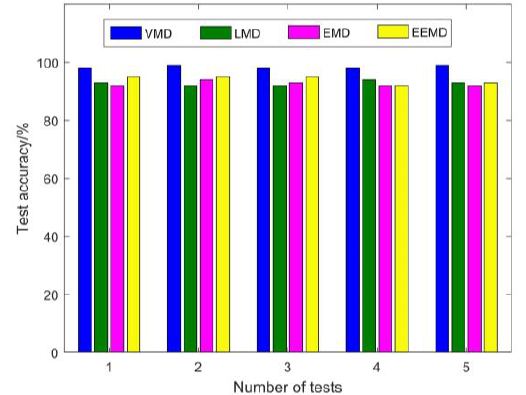
Figure 16. Comparison of experimental results. Table 7. The average recognition precision and standard deviation of the compared method.